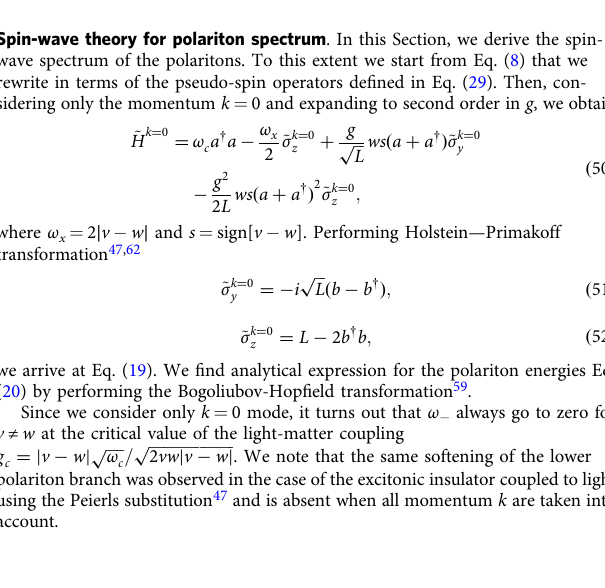
ffiffiffiffiffiffiffiffiffiffiffiffiffiffiffiffiffiffiffiffiffiffi jp p ffiffiffiffiffi j = ω 2 vw j v (cid:2) w c